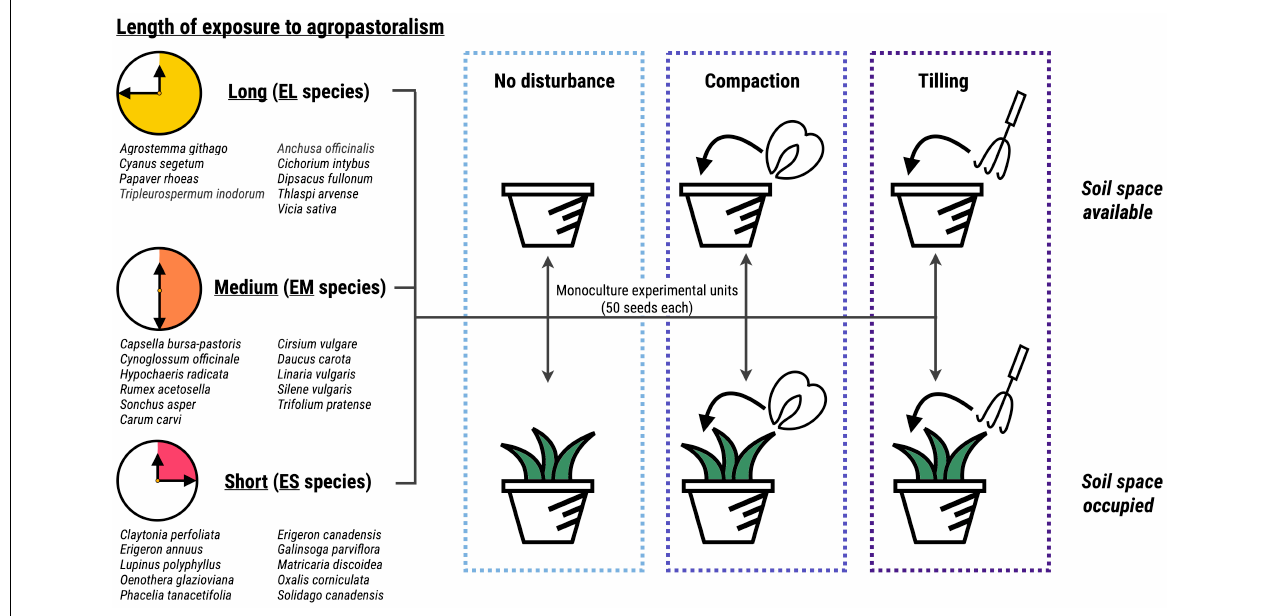
FIGURE 1 | Schematic representation of the experimental setup. We selected species attributable to three groups according to their geographical origin and therefore assumed length of exposure to agropastoralism: yellow – long exposure, orange – medium exposure, red – short exposure. Fifty seeds from a single species were sown into experimental units, which were subject to one of three disturbance treatments (light blue – no disturbance, blue – compaction, purple – tilling), crossed with two levels of space occupancy (white – available, green – occupied). Each species × disturbance × space occupancy combination was replicated with five experimental units. N experimental units =